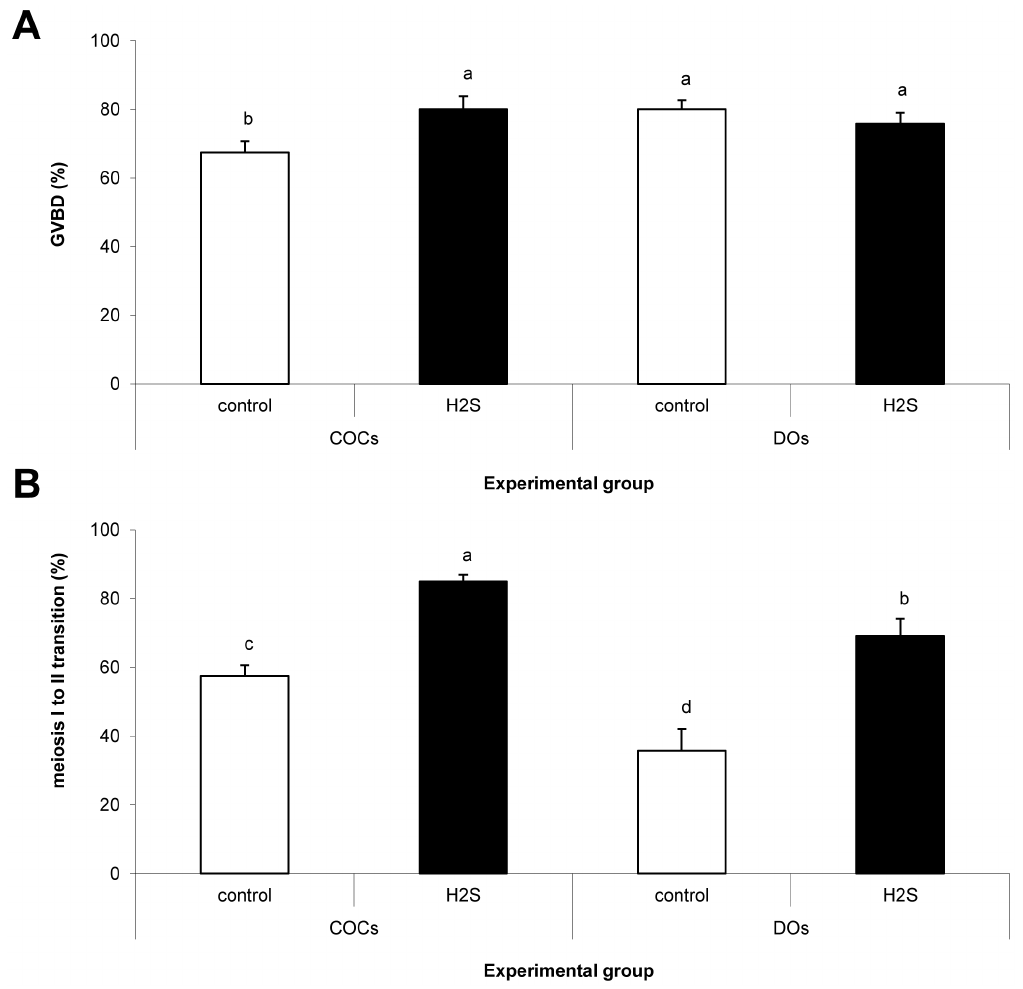
Figure 4. Effect of Na 2 S on meiosis resumption and transition to meiosis II in DOs. Proportion of GVBD (A) and meiosis I to II transition (B) during in vitro cultivation after 20 and 30 h in vitro cultivation, respectively. H 2 S: 300 m M Na 2 S. a,b,c Statistically significant differences among experimental groups (P , 0.05).